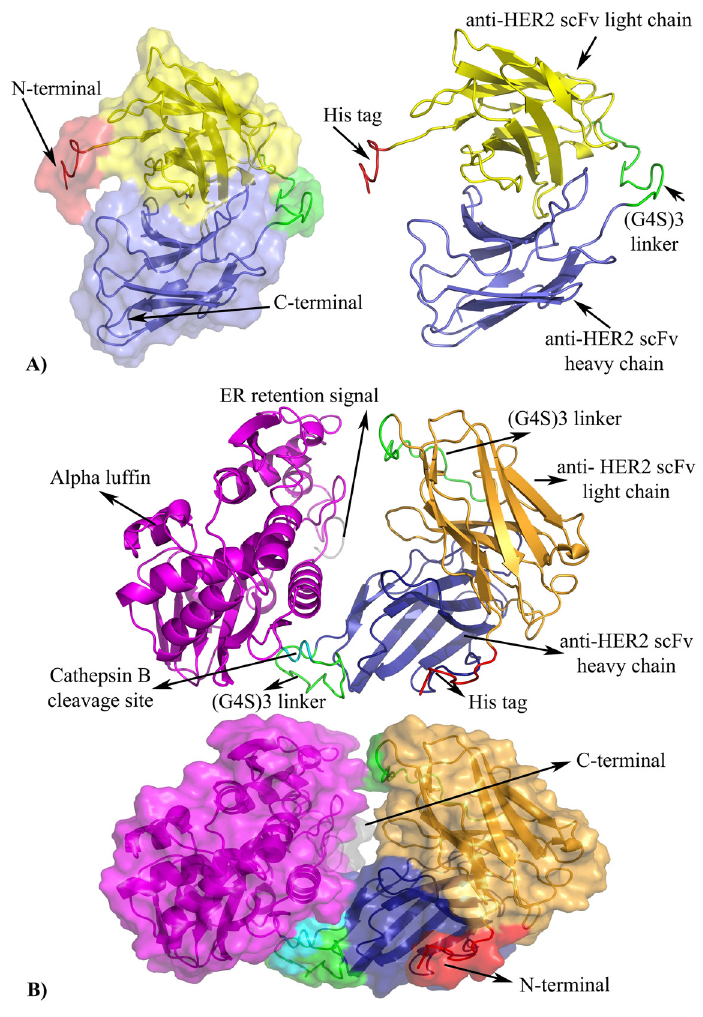
FIGURE 3 - Design of the 3D structures using PyMol: A) anti-HER2 scFv; B) Fusion